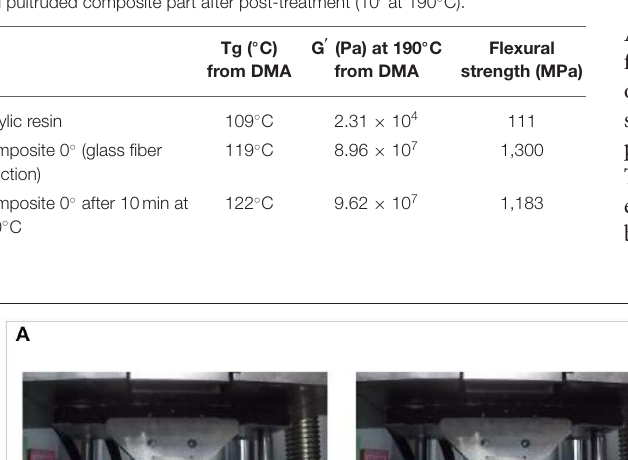
TABLE 5 | Dynamic Mechanical properties (Glass transition temperature, storage modulus at 190 ◦ C and flexural strength) of neat resin, pultruded composite part and pultruded composite part after post-treatment (10 ′ at 190 ◦ C).